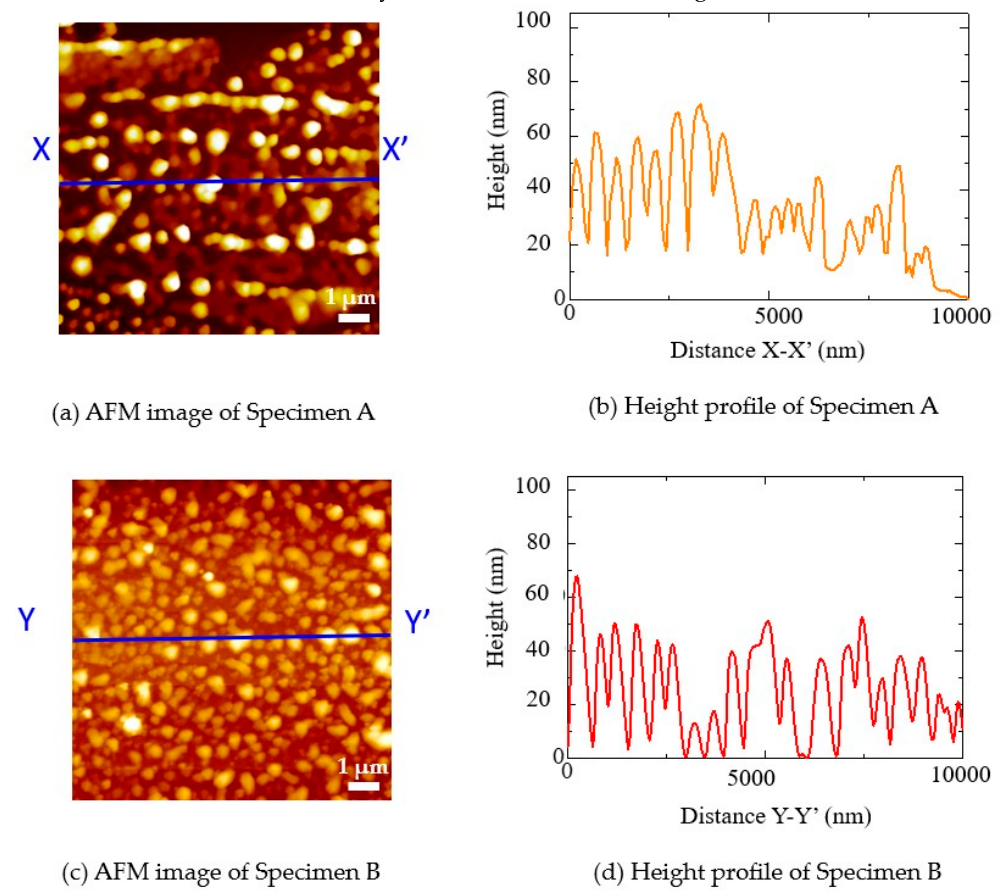
Figure 6. Atomic Force Microscopy (AFM) image and height profiles of the annealed quartz